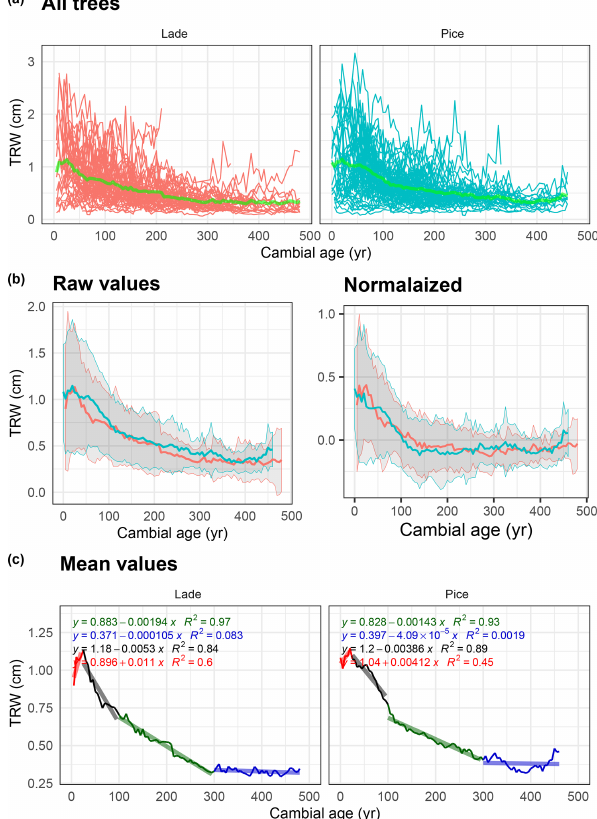
Figure 5. Analysis of δ D data: (a) normalized δ D values of all larch (LADE, red) and cembran pine (PICE, green) trees; the green line corresponds to the mean. (b) Raw (left) and normalized (right) mean value with corresponding ± 1 standard deviation (gray area) of larch (red) and cembran pine (cyan). (c) Plots of the mean values with lin- ear approximations for the periods 1–50, 51–100, and > 100 years.